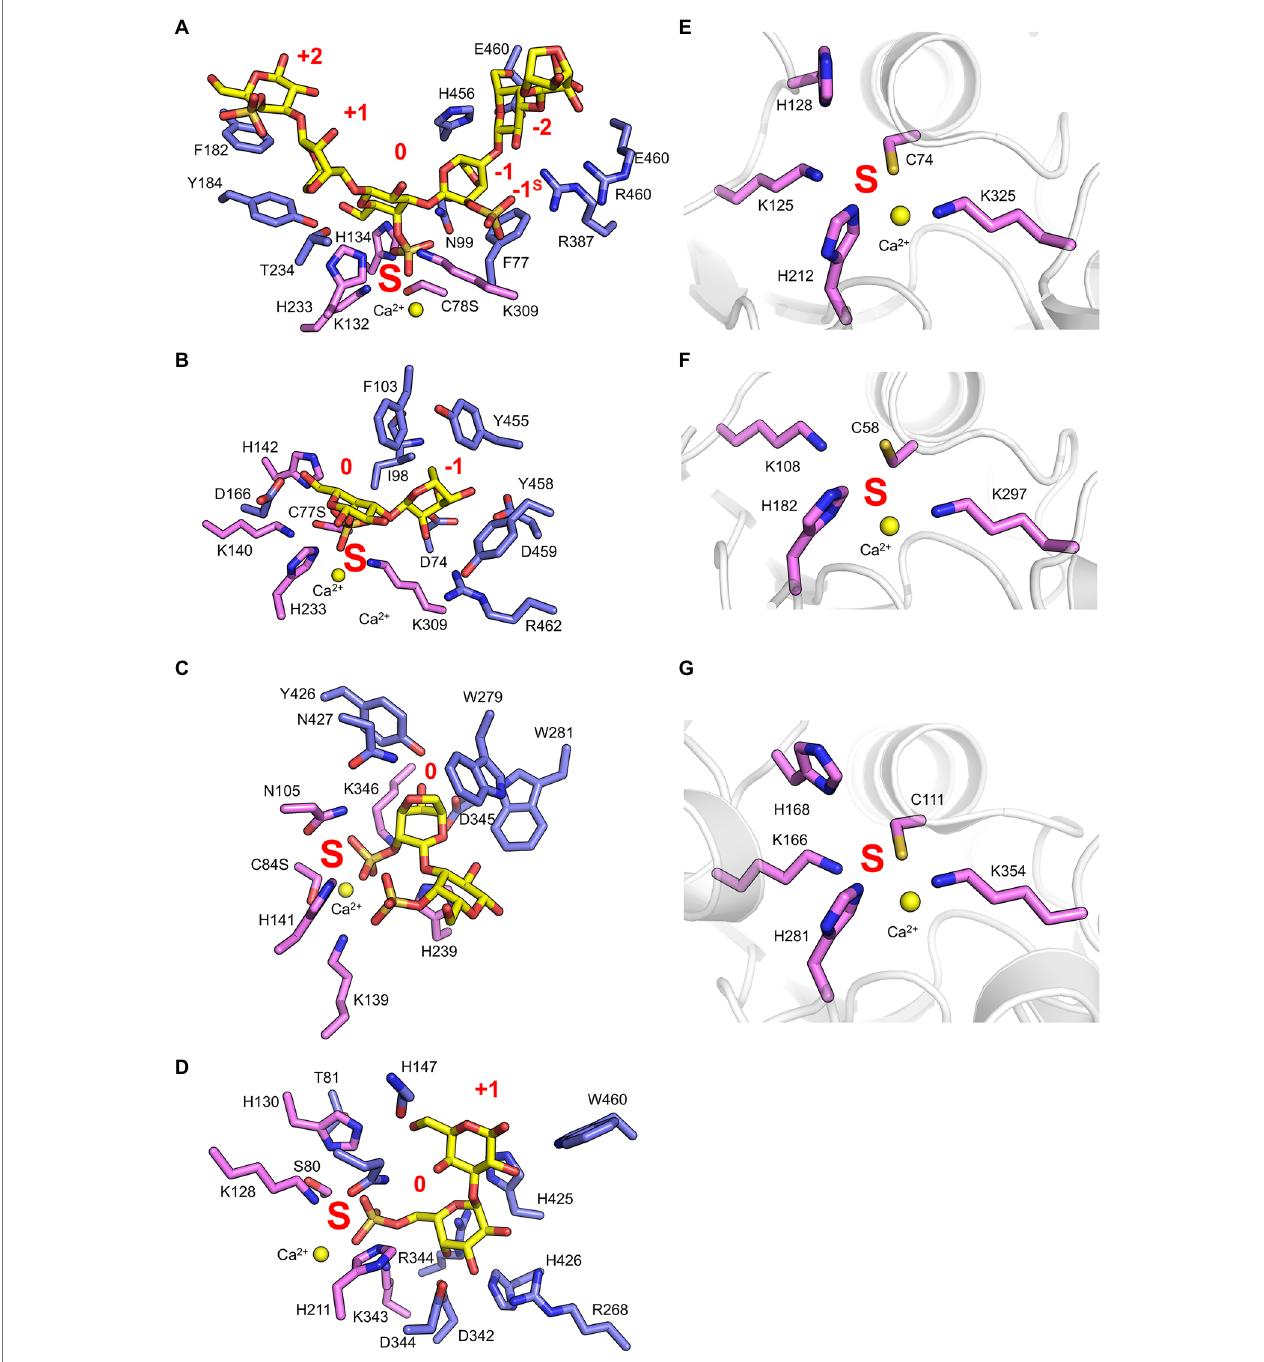
FIGURE 4 | Marine carbohydrate-specific sulfatases in complex with their biological substrates. The X-ray crystal structure of PfS1_19A C78S in complex with a κ - ι - κ -carrageenan hexasaccharide [PDB ID: 6B0J, Hettle et al. (2018)] (A) , PfS1_19B C77S in complex with a κ -carrageenan disaccharide [PDB ID: 6PSM, Hettle et al. (2019)] (B) , PfS1_NC C84S in complex with an ι -carrageenan disaccharide [PDB ID: 6PT6, Hettle et al. (2019)] (C) , BuS1_11 S80 in complex with neoporphyrabiose [PDB ID: 7LJ2, Robb et al. (2022)] (D) , P18_S1_7 [PDB ID: 6HHM, Reisky et al. (2019)] (E) , P36_S1_25 [PDB ID: 6HR5, Reisky et al. (2019)] (F) and PsFuc1 [PDB ID: 7AJ0, Mikkelsen et al. (2021)] (G) . In all panels, S-subsite residues are shown in pink sticks, integer-subsites as purple sticks, the calcium ion is represented as a yellow sphere, and the subsites are labelled in red. In panels (A–C) oligosaccharides as yellow sticks, and in panels (D–F) the peptide backbone is shown in grey cartoon